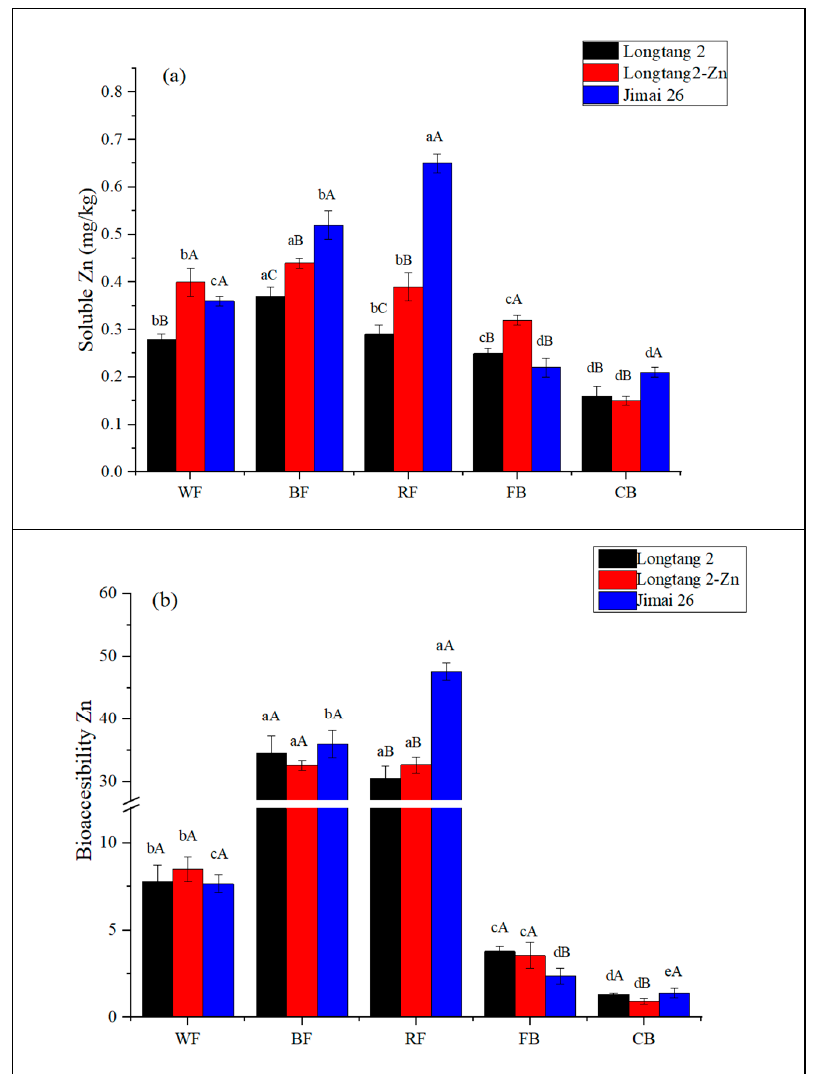
Figure 1. ( a ) Soluble Zn and ( b ) bioaccessibility of Zn in milling fractions of LT2, LZ2, and JM26. Longtang 2 (LT2) was used as the control sample; Longtang 2 with foliar fertilization will be referred to as Longtang 2-Zn (LZ2); the other selected wheat Jimai26 (JM26) was a high-zinc variety. WF: whole flour; BF: B flour; RF: R flour; FB: fine bran; CB: coarse bran. Data are expressed as mean ± standard deviation ( n = 3). For the same parameter, means with different superscript lowercase letters within different milling fractions of the same wheat species are significantly different ( p < 0.05), and means with different superscript uppercase letters between within different wheat samples of the same milling fractions are significantly different ( p <